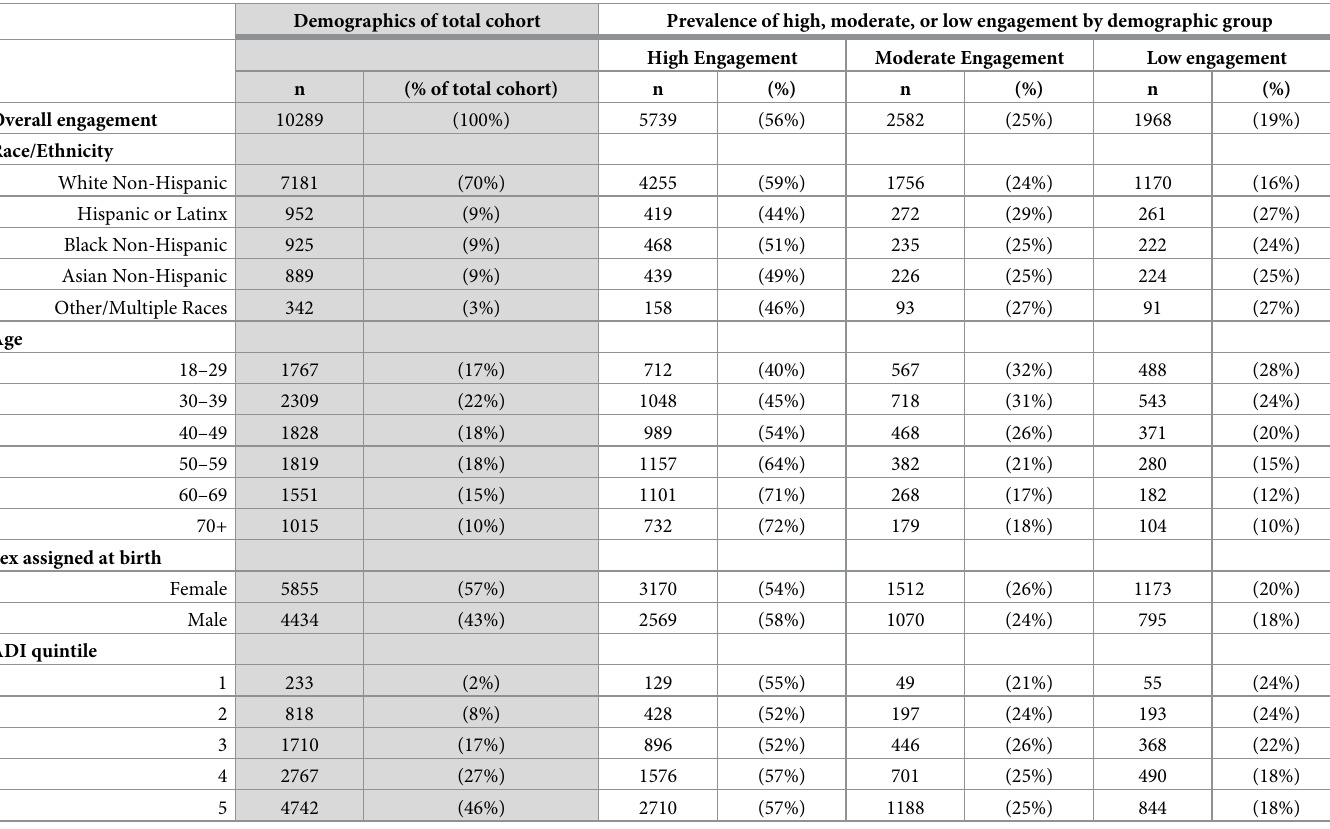
Table 1. Longitudinal retention & engagement based on kit completion.